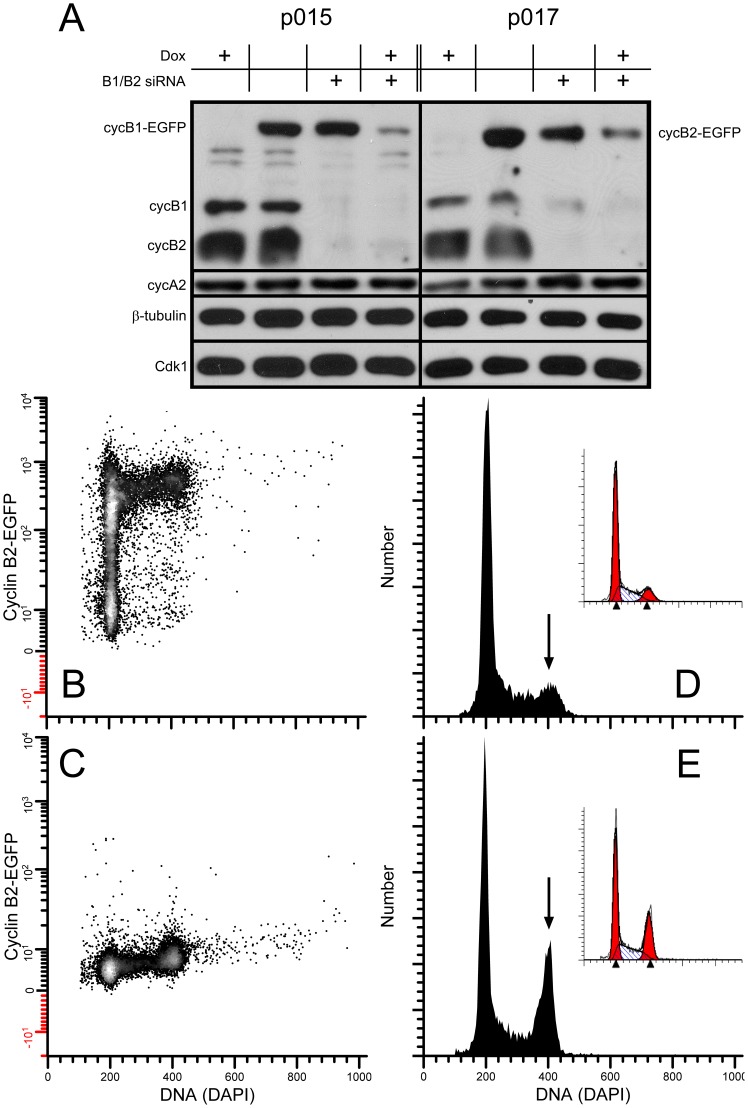
B cyclin co-depletion induces G2 arrest.HeLa-p015-4 and HeLa-p017-4 cells were transfected with control siRNA or B cyclin siRNAs in the presence or absence of Dox for 24–30 hours. Cell lysates were then subjected to electrophoresis and immunobloting (A) or fixed and stained for flow cytometry (B). A: Immunoblot analysis of cyclin B1 (cycB1), cyclin B2 (cycB2), cyclin A2 (cycA2), Cdk1, and β-tubulin under noted conditions. B, C: example cyclin B1-EGFP expression for p015 in the absence (B) or presence (C) of Dox. D, E: DNA content histograms of control cells without Dox (D) or co-depleted cells with Dox (E). Arrows point to 4C cells. Cells depicted in E are both co-depleted for endogenous cyclins and repressed (Dox treated) for exogenous cyclins.